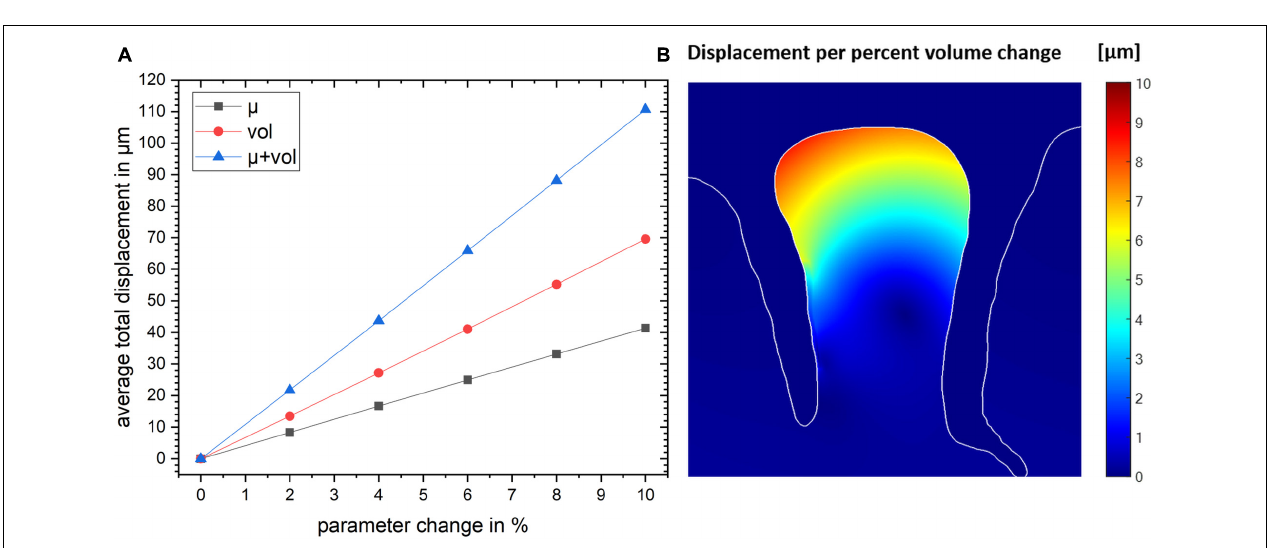
FIGURE 4 | (A) The total displacement for the gyrus crown as a function of parameter change for the three simulation studies. (B) The spatial map of the resulting displacement given in per percent volume change. Color map shows the magnitude of local displacement.